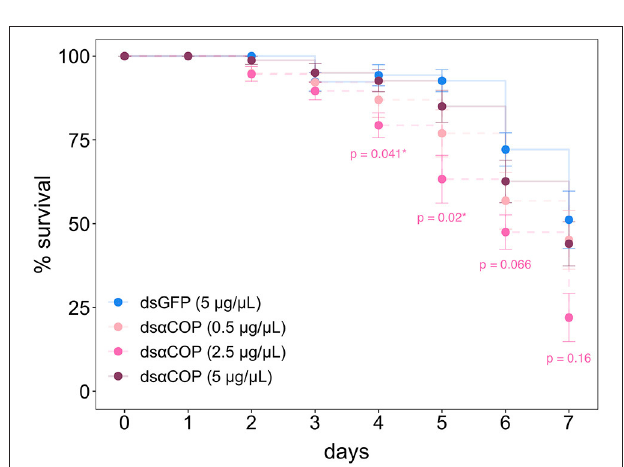
FIGURE 2 | Survival curves, comparing the mortality effect of ds α COP treatments to the dsGFP control treatment in B. aeneus larvae. Starting n = 10 (10 cages of 8 larvae) per treatment. Data were analyzed via Kruskal–Wallis test, followed by the Wilcoxon rank-sums test with post-hoc Bonferroni correction for multiple comparisons (error bars: ± SEM). An asterisk indicates a significant difference between ds α COP and dsGFP treatment. * = p <